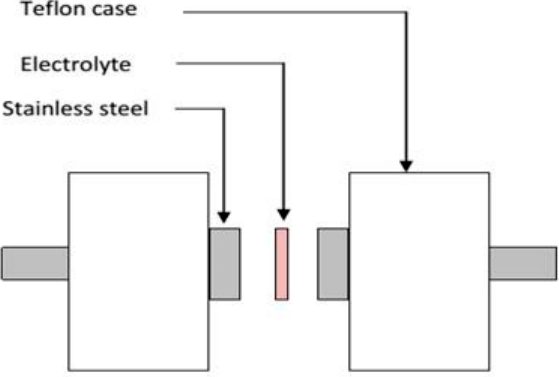
Figure 17. Schematic diagram of cell arrangement for LSV, TNM and impedance study.